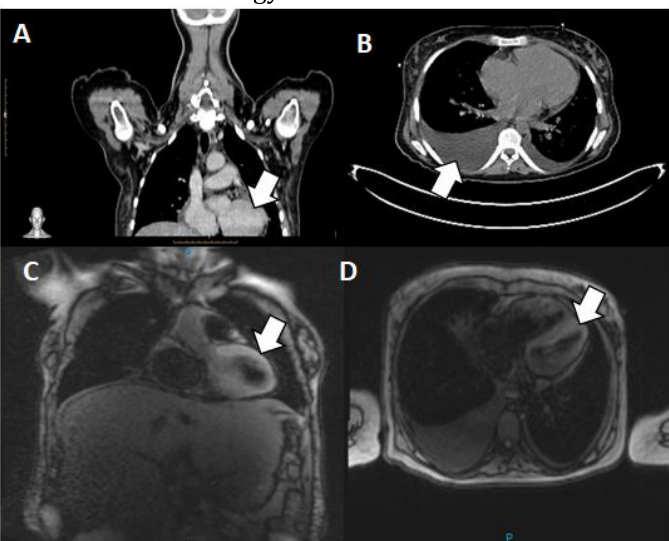
Figure 1 . RM and PET Imagens. Sagittal view (A, C) and axial view (B, D) show a tumor in right ventricle and pleural effusion (Arrows).